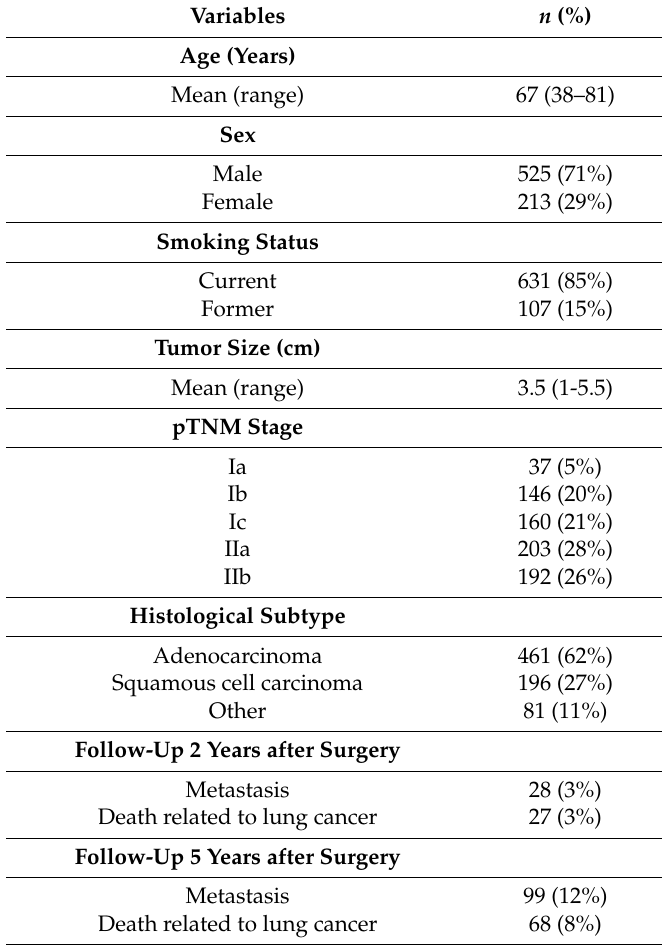
Table 2. Main epidemiological parameters associated with the cohort of early-stage NSCLC patients (total of 738 former or current patients).